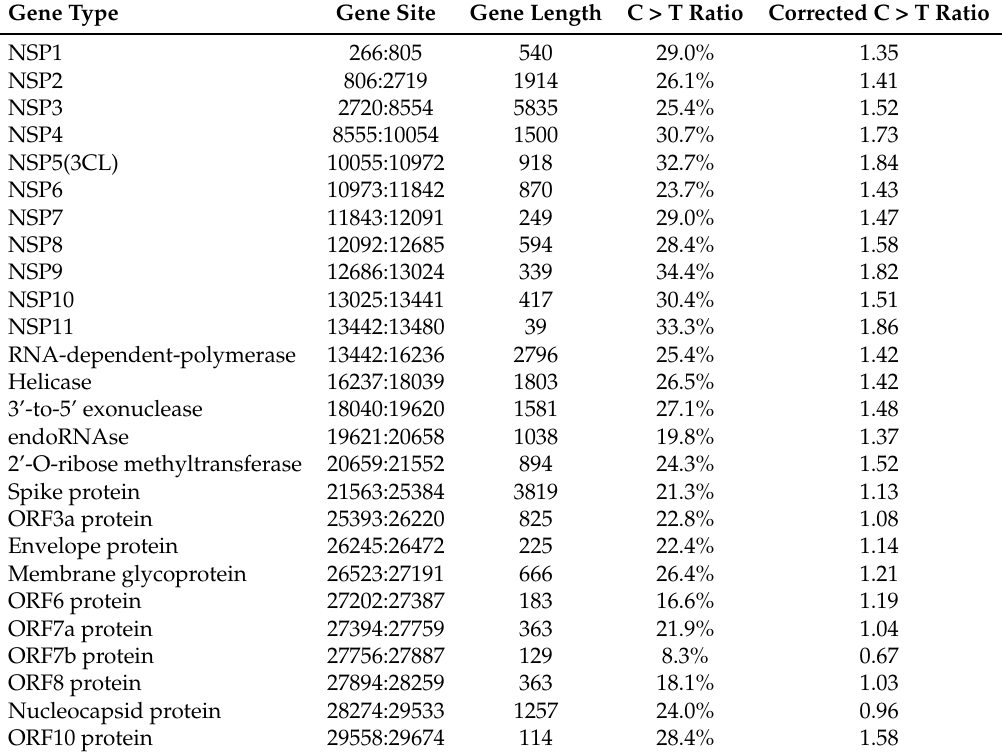
Table 5. C > T ratios on 26 SARS-CoV-2 proteins. For each gene, the “corrected C > T ratio” is computed by dividing its C > T ratio with the ratio of C in the